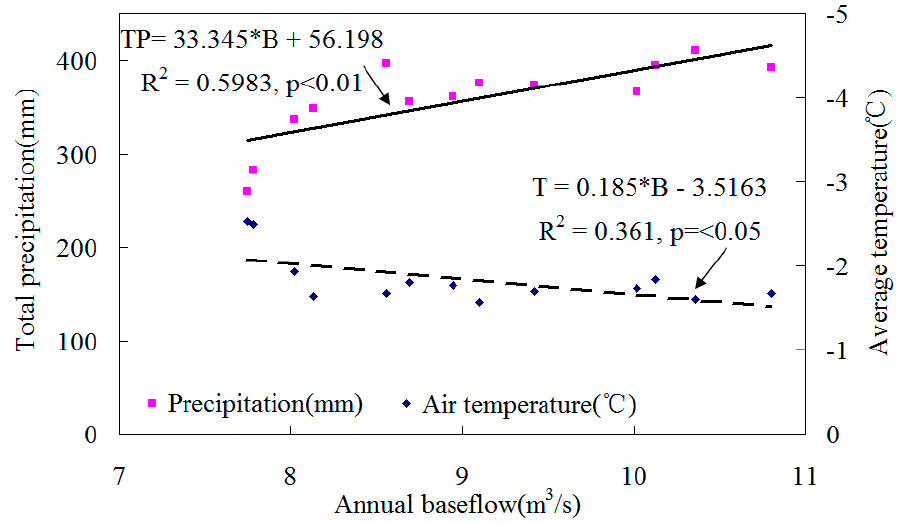
Figure 9. The relationship between the annual baseflow (B) and total precipitation (TP) (with the solid trend line), and the relationship between the baseflow (B) and temperature (T) (with the dotted trend line), in the study area during the period from 1996 to 2009.